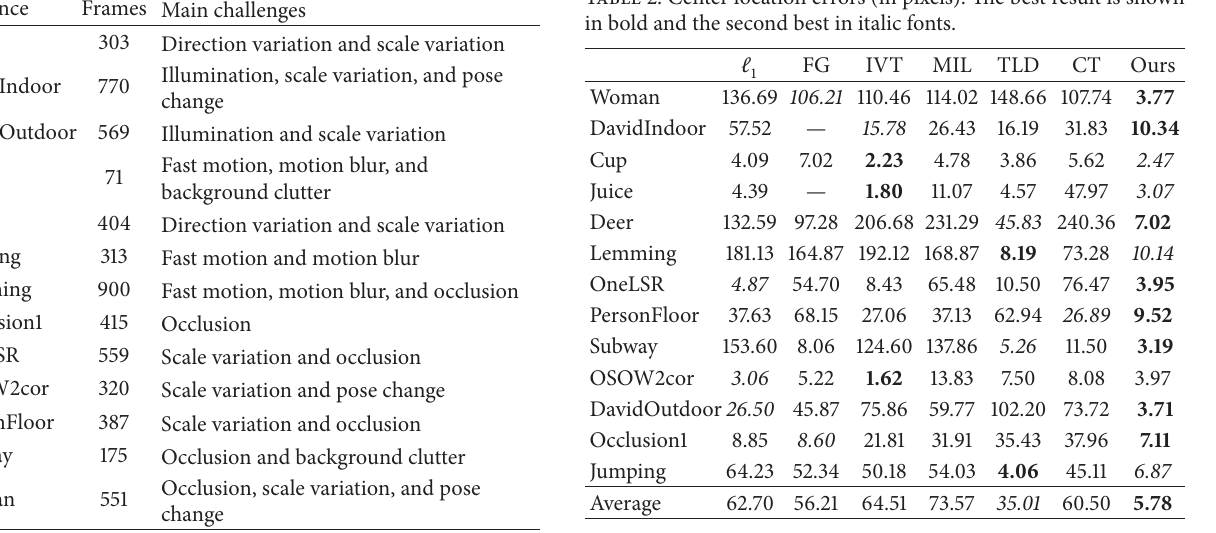
Algorithm 1: Tracking based on proposed method. Table 1: The tracking sequences used in our experiments. Sequence